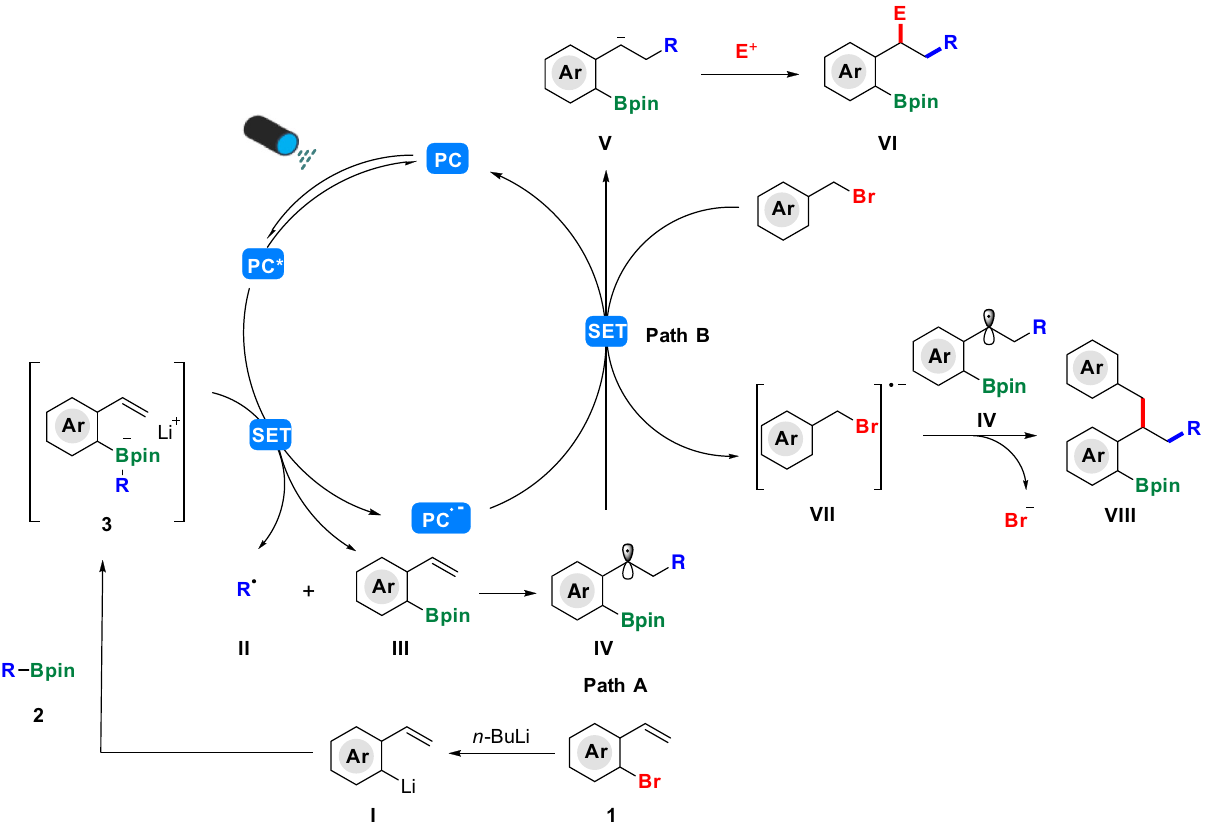
Fig. 8 Proposed mechanism. Ar = aromatic ring; R = alkyl chain; SET = single electron transfer; Bpin = boronic acid pinocol ester; PC = photocatalyst; PC* = the excited state photocatalyst; P .- = the reduced state of the photocatalyst; E =